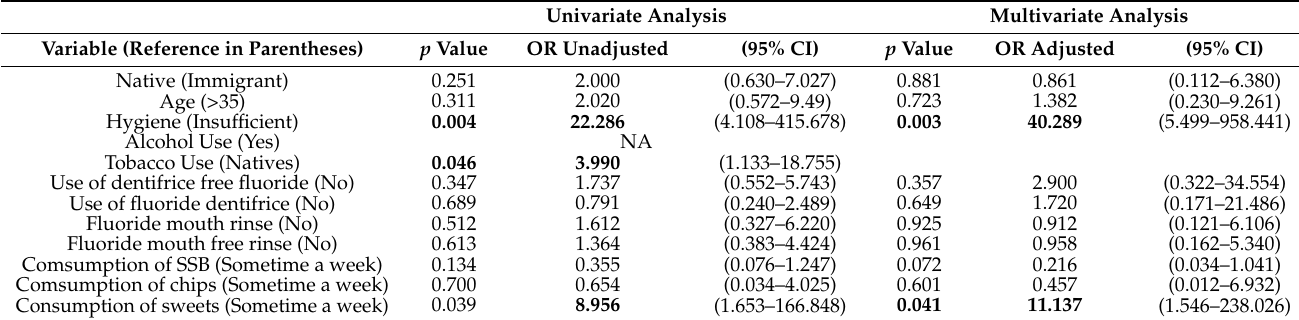
Table 3. Caries risk in pregnant women. Univariate and multivariate logistic regression. OR: odd ratio. CI: confidence interval. In bold letter, statistically significant p-values and valid OR.